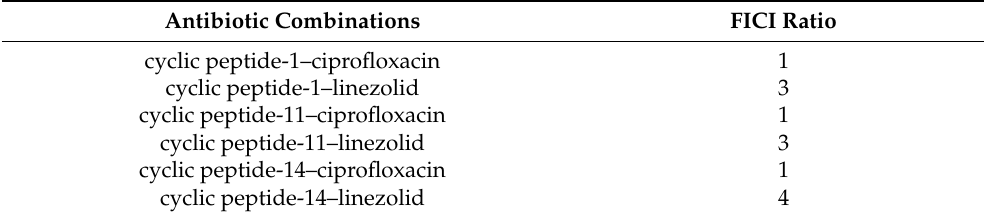
Table 3. The activities of antibiotics in combination with antibiotics against MRSA ATCC 43300.